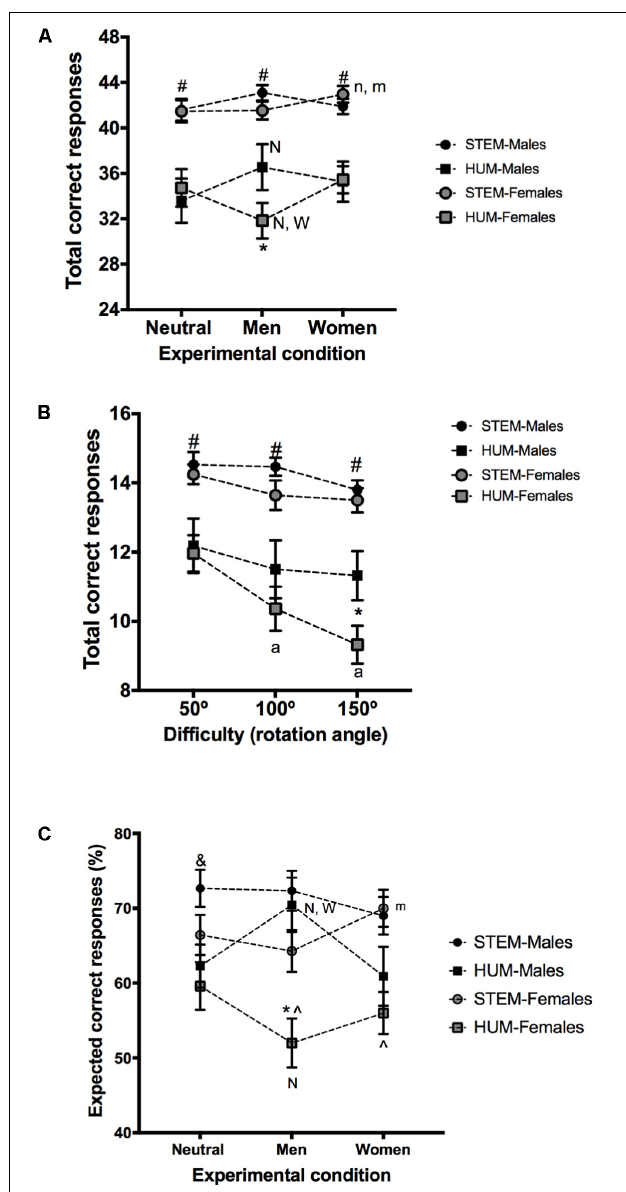
FIGURE 2 | 3DMRT observed and expected performance. (A) Depicts the observed performance (mean ± SEM of the number of correct responses) in a mental rotation task run under three experimental conditions (“neutral,” “optimized for men” and “optimized for women”). (B) Illustrates the relationship between task difficulty (rotation angle) and 3DMRT observed performance (mean ± SEM of correct responses) for each participant’s group for the “optimized for men” condition. (C) Shows expected performance (mean ± SEM of the participants’ expected percentage of correct responses) as a measure of task execution confidence in each experimental phase (see the Measures section for details). Note that in (A,B) , the Y -axis were adjusted to denote optimal and chance levels performance [ # Significantly different from HUM groups; ∧ Significantly different from STEM groups; ∗ Significantly different from HUM-Males; & Significantly different from HUM-Females; N, n Significantly different from the “neutral” condition ( p < 0.01 and p < 0.05, respectively); W Significantly different from the “optimized for women condition” ( p < 0.01); m Significantly different from the “optimized for men” condition ( p < 0.05); a Significantly different from the 50 o rotation angle ( p <